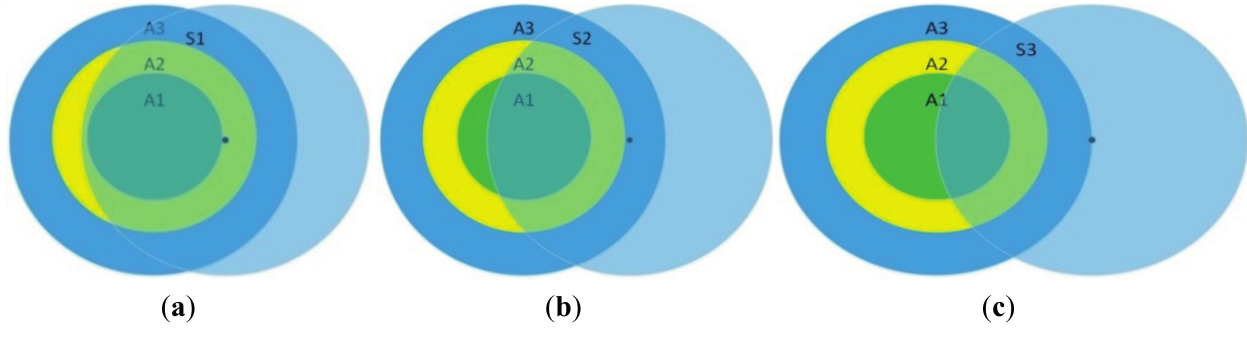
Figure 7. An example of how to divide MSA when k = 3.